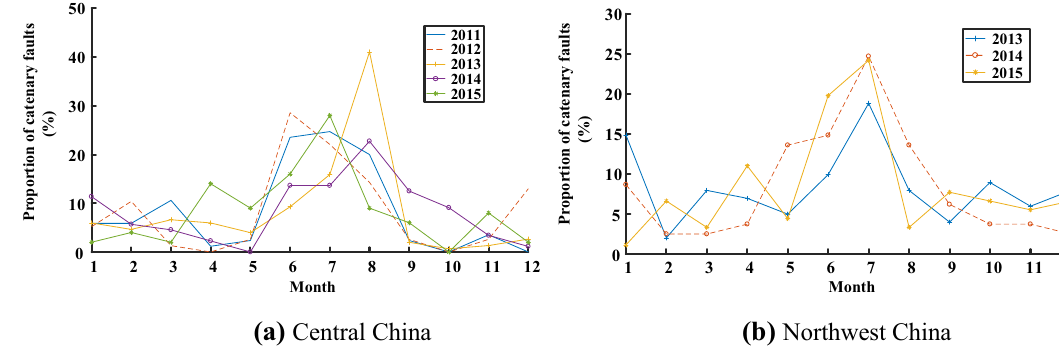
Fig. 3 Proportion of catenary faults in different regions in China